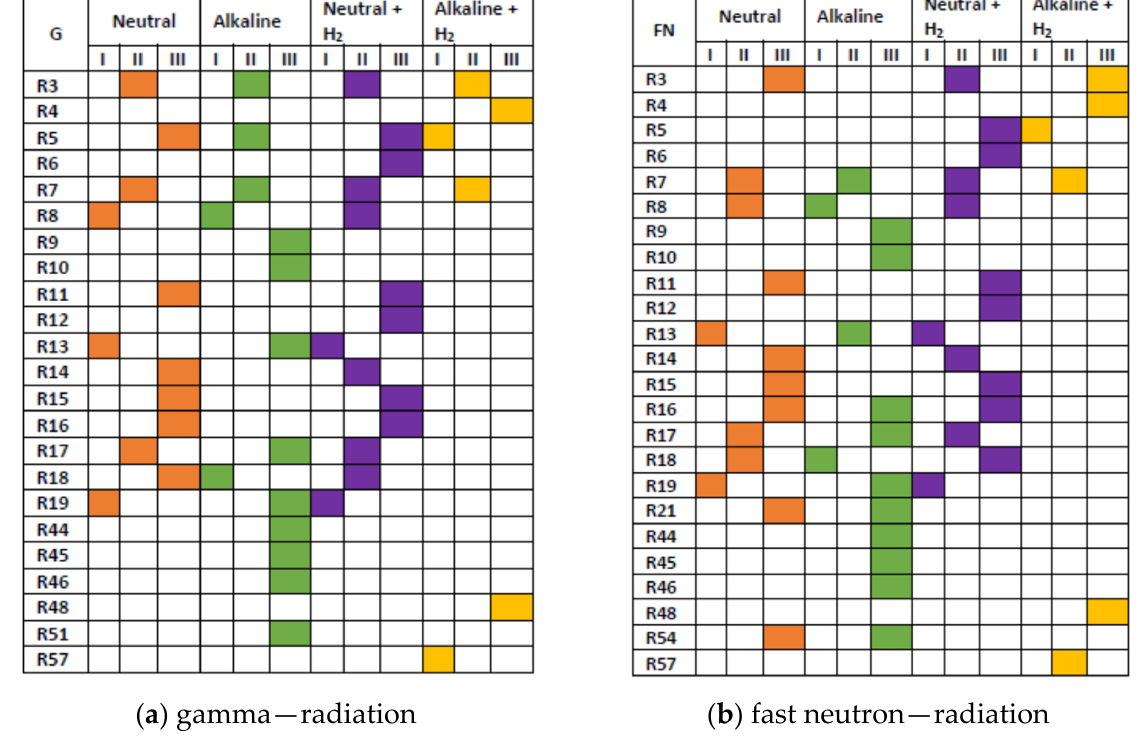
Scheme 3. Graphical presentation of importance of reactions from Table 2. The integrated contribu- tions R were classified into categories I, II, and III, defined in the text above the scheme. Colours correspond to neutral water (orange), alkaline solution (green), and hydrogenated (3·10 − 5 mol·kg − 1 H 2 ) systems: neutral (violet) and alkaline (yellow). Based on the simulation for 1 kGy·s − 1 .